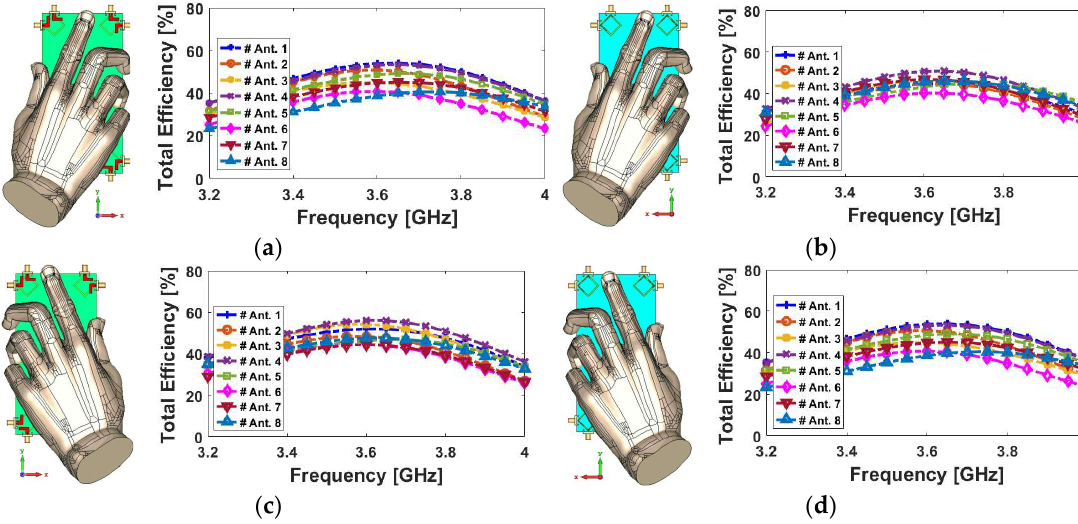
Figure 18. Placement and total efficiencies of the design for different user-hand scenarios ( a ) right-hand/top-layer, ( b ) right-hand/back-layer, ( c ) left-hand/top-layer and ( d ) left-hand/back-layer.